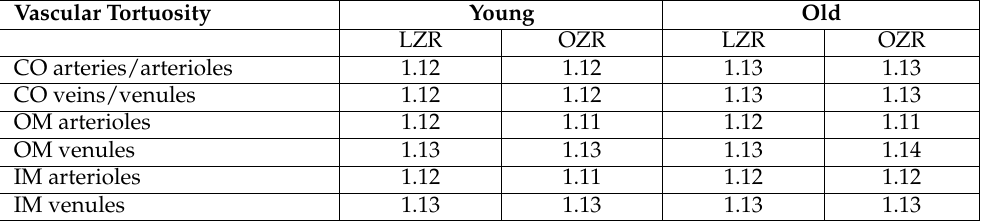
Table 4. Renal vascular tortuosity in lean Zucker rats (LZR) and obese Zucker rats (OZR) at the age of 11 and 20